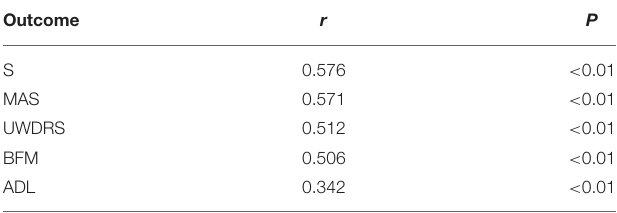
TABLE 2 | Pearson correlation analysis between F value measured by MyotonPRO device with the S value, the score of MAS, UWDRS, BFM, and ADL